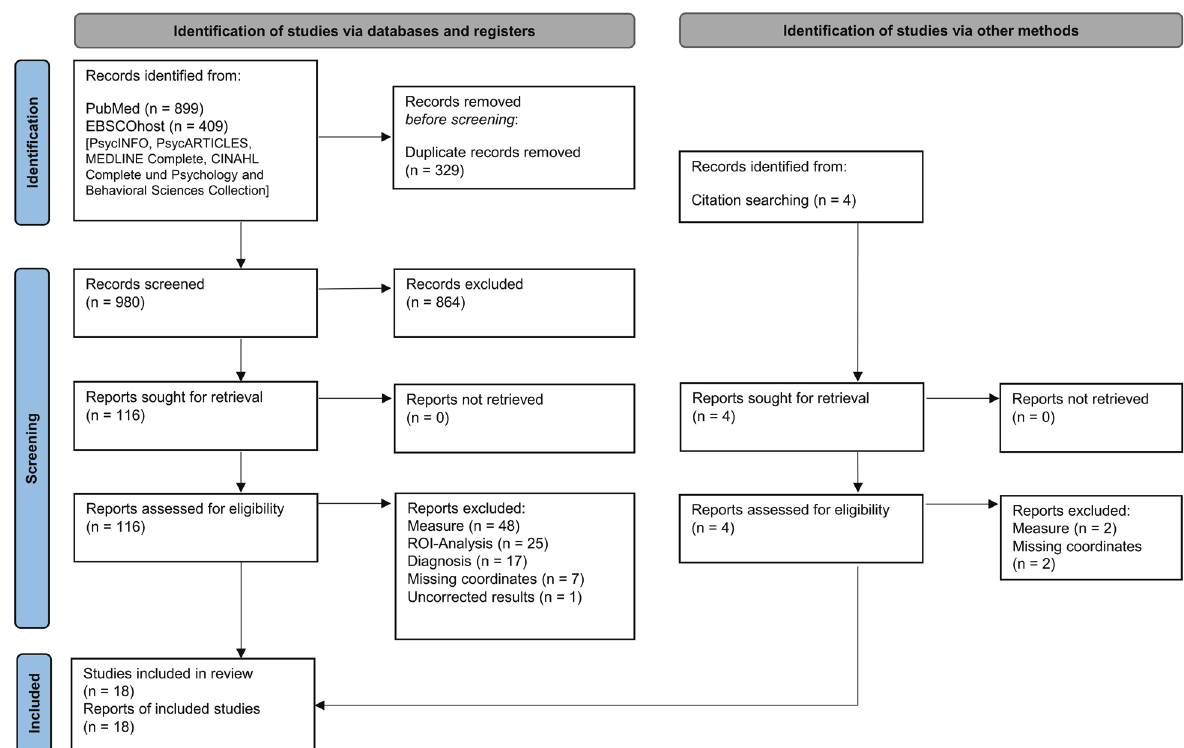
Fig. 1 Stages of systematic literature search and selection: Flow diagram according to the PRISMA Guideline from Page et al. (2021)